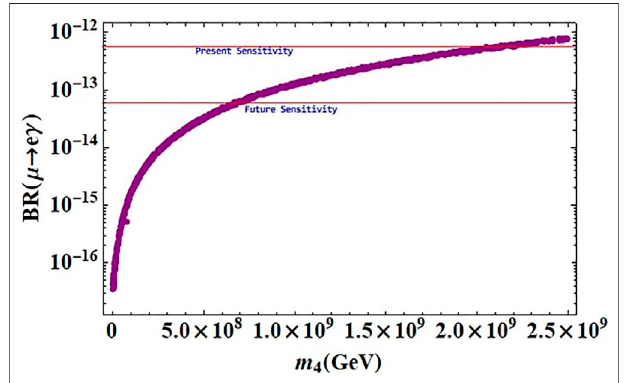
FIGURE8| BR( μ − e c )asafunctionofthesterileneutrinomass.Thered horizontal line represents the experimental bounds on this process.